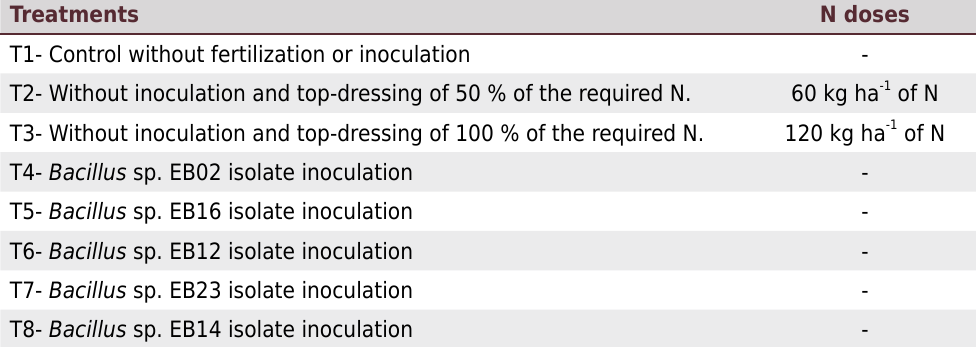
Table 2. Description of experimental treatments